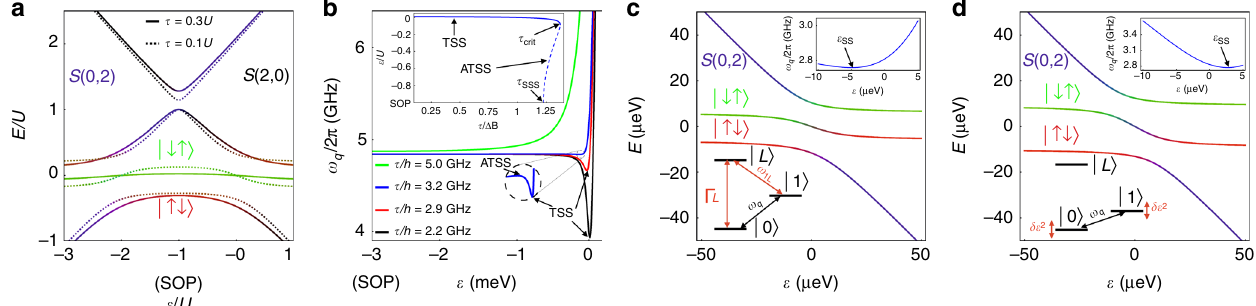
Fig. 2 Operating regimes of the transversely coupled sweet spot (TSS) of a S − T 0 qubit. a Energy level diagrams obtained from Hamiltonian (1) assuming that the tunnel coupling τ and the fi eld difference between the dots Δ B obey τ > Δ B (solid lines), or τ < Δ B (dashed lines). In both cases we take Δ B ¼ 0 : 2 U , where U is the double-occupation charging energy. Singlet-triplet qubits are often operated at either the symmetric operating point (SOP), where ε ¼ (cid:1) U , or near the S ð 1 ; 1 Þ - S ð 0 ; 2 Þ charging transition for the singlet state, where ε ¼ 0. b The TSS and the alternative TSS are indicated on the qubit dispersions ω , obtained for Δ B = h ¼ 2 : 5 GHz and several different values of τ . We also assume U ¼ 3 meV here, and throughout this work. For q τ (cid:4) τ τ (cid:4) τ , a TSS dip forms near ε ¼ 0 (black arrows). For τ , a very shallow ATSS peak also emerges, to the left of the TSS (lower inset). The crit SSS (cid:4) crit values of τ and τ both depend on Δ B . Upper inset: the location of the various sweet spots and critical points in detuning space, for Δ B = h ¼ 2 : 5 GHz. crit SSS c , d Energy level diagrams near the charging transition, showing two types of behavior (main panels), and their corresponding qubit energy splittings ω (upper insets) and sweet spots ( ε ). c For τ > Δ B , we observe ε 0. Degenerate energy levels ( ω ) near the TSS can induce unwanted excitations q (cid:3) 1 L SS SS < to the leakage state L j i (lower inset), with decay rate Γ L ¼ 1 = T L . (Here, τ = h ¼ 1 : 75 GHz and Δ B = h ¼ 1 : 5 GHz.) d For τ ≲ Δ B , we observe ε 0. In this SS > case, the excitation energies are no longer degenerate at the TSS, suppressing leakage, but the qubit is more charge-like, and therefore susceptible to fl uctuations of the detuning parameter δε . At the sweet spot, the dominant fl uctuations occur at O½ δε 2 (cid:6) , causing weak dephasing. (Here, τ = h ¼ 1 : 5 GHz and Δ B = h ¼ 2 : 5 very small, in terms of the parameter ð Δ B = U Þ m (cid:5) 1, yielding an (and an exact approximate ninth-order sweet spot when τ ¼ τ SSS third-order sweet spot), which accounts for the extreme fl atness of the energy dispersion.